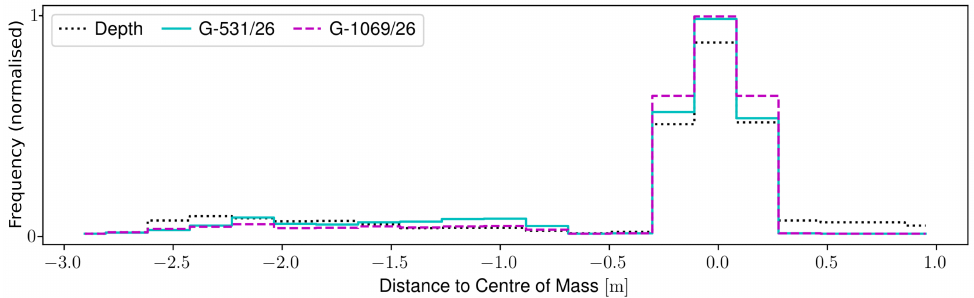
Figure 7. Normalised estimate of laser ranging returns based on the scene in Figure 4. Observation bands are given in Figure A1.